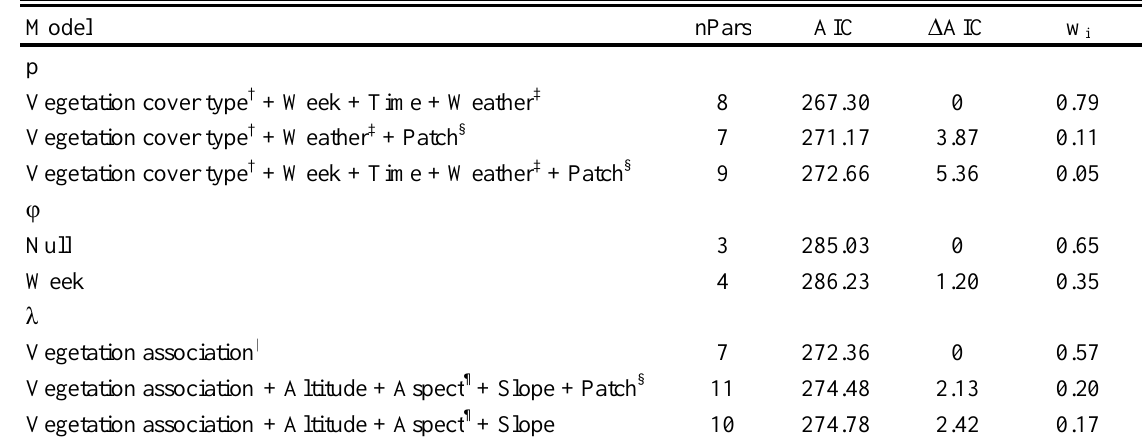
Table 3. Number of parameters (nPars), Akaike information criterion (AIC), ∆ AIC, and Akaike weights (w for the 95% confidence set of candidate models of Buff-throated Partridge ( Tetraophasis szechenyii ) abundance ( λ ), availability ( φ ), and detection probability (p).